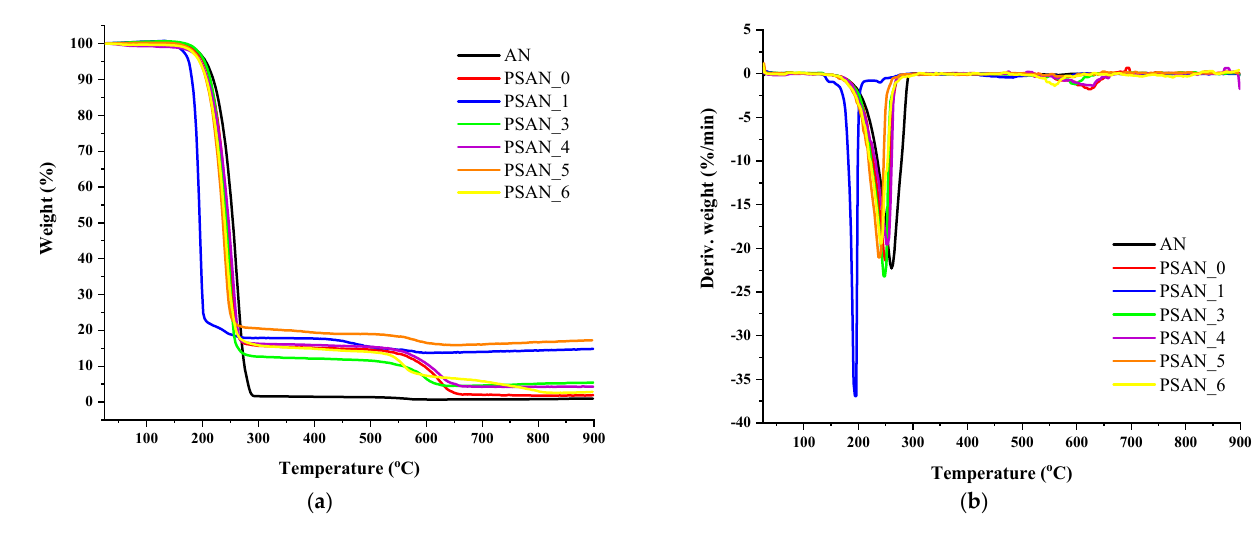
Figure 4. Multigraph with TGA ( a ) and DTG ( b ) thermograms for the PSAN specimens. Table 4. Thermal properties of synthesized PSAN formulations.